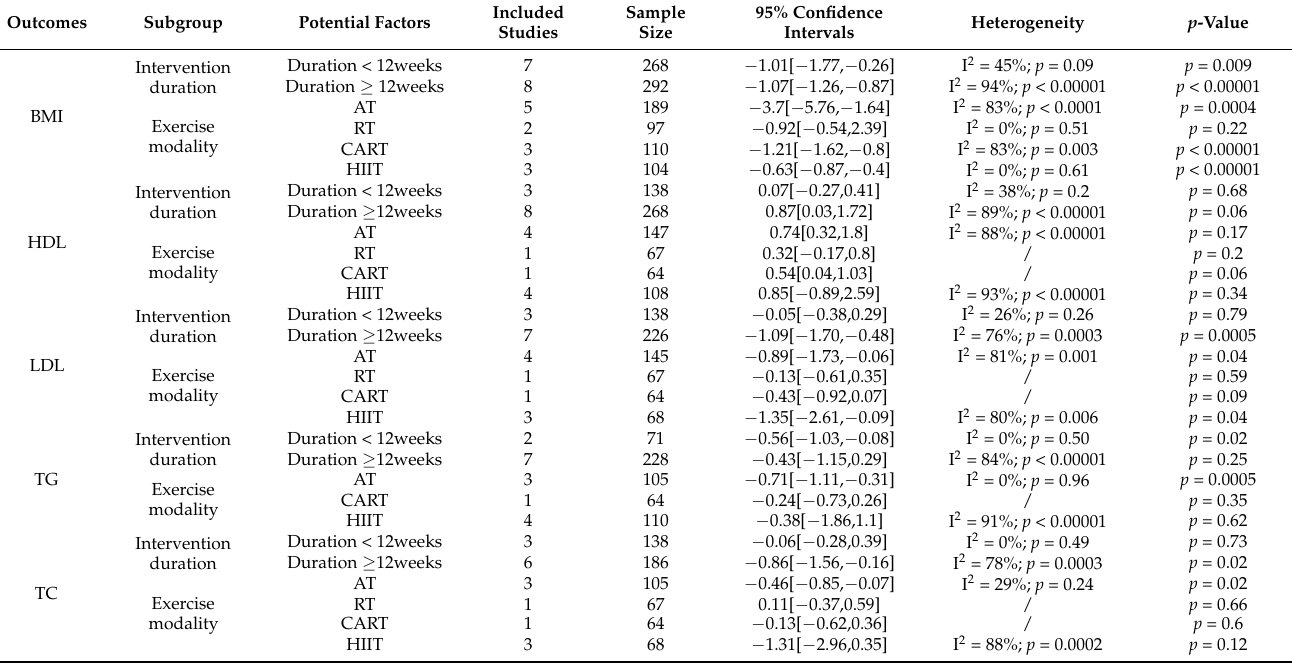
Table 3. Subgroup analyses in obese adolescents.